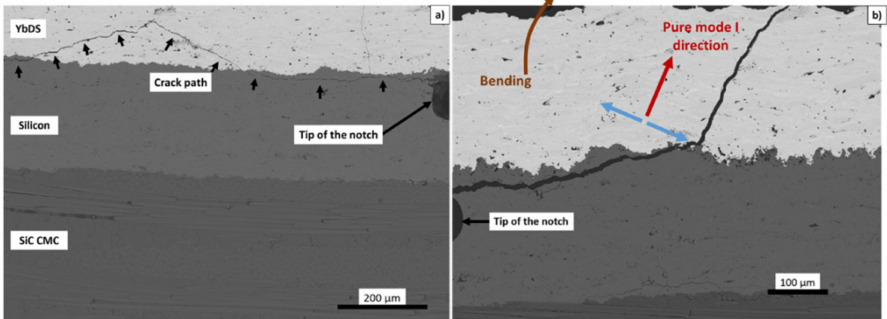
Figure 10. Interface and course of cracking of an unstructured ( a ) and a structured ( b ) specimen after the interface toughness